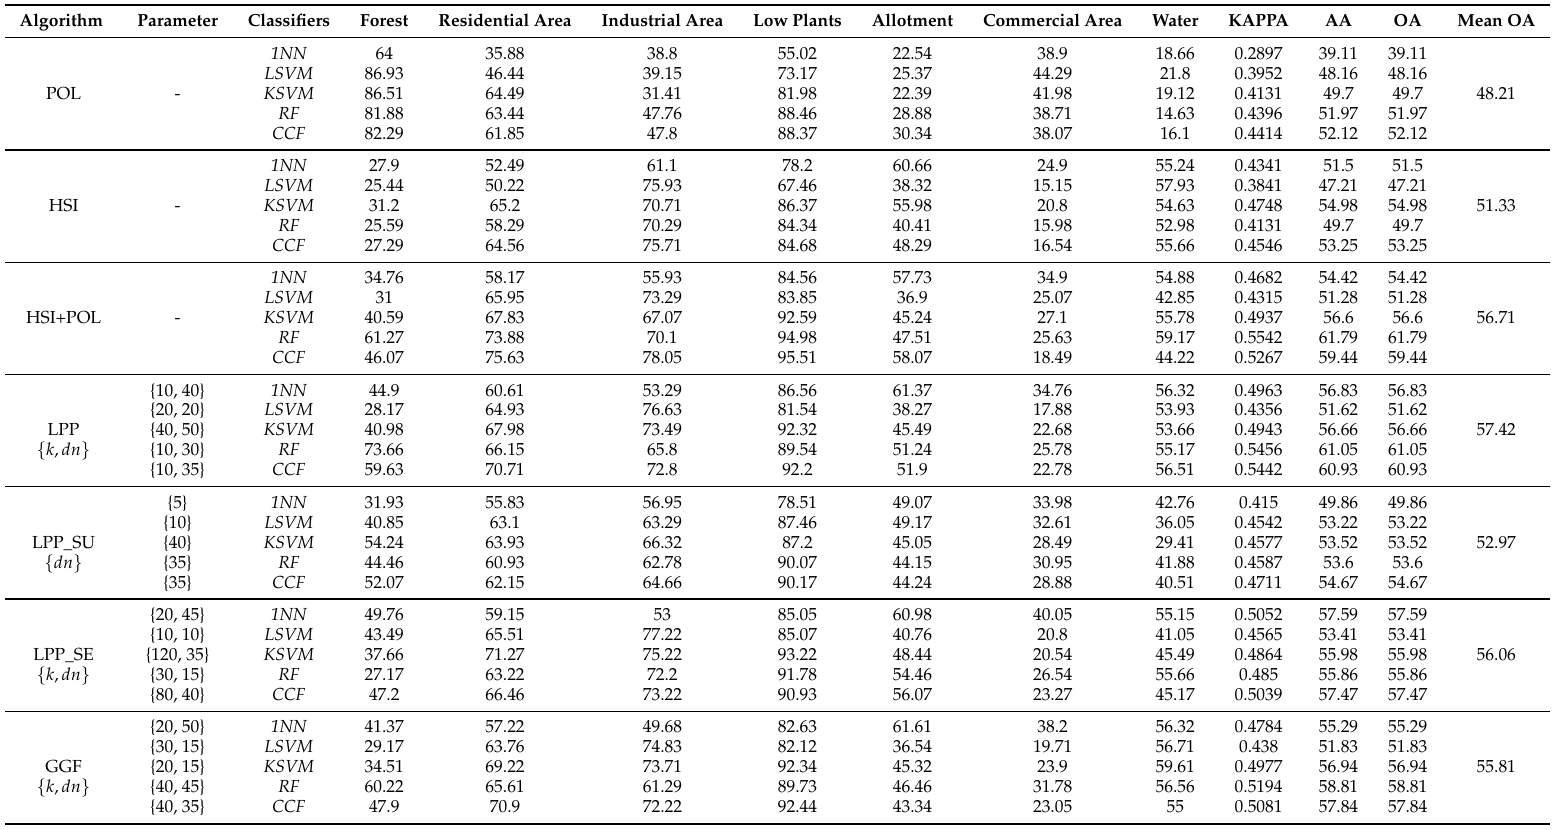
Table 6. Quantitative performance comparison on the Augsburg data, in terms of class-specific accuracy, kappa coefficient, average accuracy, overall accuracy, and mean overall accuracy. The mean overall accuracy is calculated based on the overall accuracies achieved by the five classifiers. The listed indications are achieved after hyperparameter tunning. The hyperparameters of each algorithm are listed under the name of the algorithm and their values are listed in the table. The kappa coefficient, average accuracy, and the overall accuracy that larger than 0.56, 62.5%, and 62.5% are marked in bold. And the three highest mean overall accuracies are also marked in